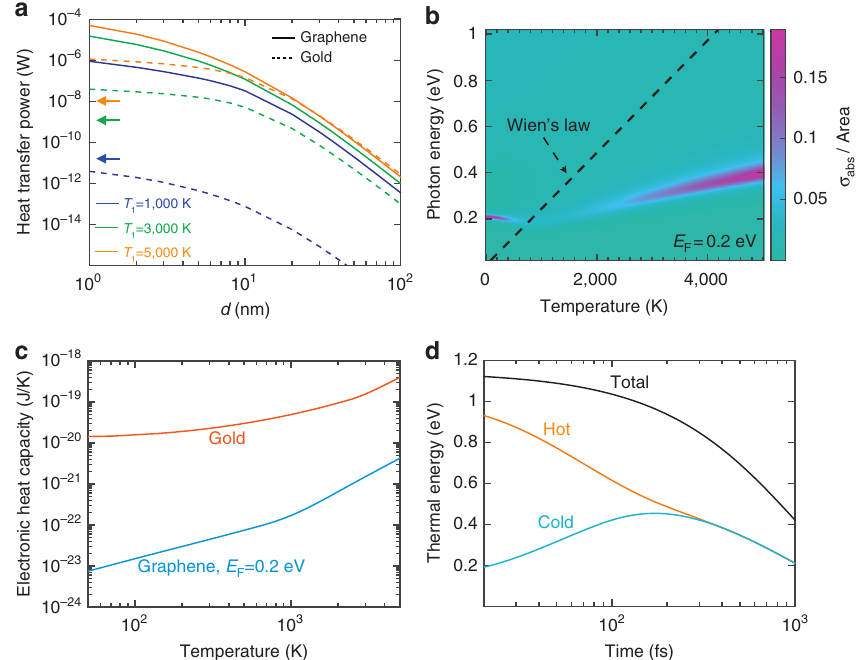
Fig. 2 Thermal and optical properties associated with radiative heat transfer. a Dependence of the radiative heat transfer power ( HTP ) on the separation distance d between two graphene nanodisks ( solid curves ) compared with two gold nanodisks ( dashed curves , disk thickness t = 2 nm). All disks are 20 nm in diameter. The HTP is plotted for different values of T 1 (see legend), while the cold disk is at ambient temperature T 2 = 300 K. The arrows indicate the HTP between two blackbodies of an area equal to that of the present disks and placed at temperatures T 1 and T 2 . Both graphene nanodisks are assumed to be doped with the same Fermi energy E F1 = E F2 = 0.2 eV and described by the local-RPA conductivity (see Methods). b Optical absorption cross-section σ abs normalized to the graphene area for one of the graphene disks considered in a as a function of photon energy (cid:1) h ω and temperature T . The dashed line corresponds to Wien ’ s law, (cid:1) h ω (cid:7) 2 : 82 k B T . c Temperature dependence of the electronic heat capacity for one of the graphene ( blue curve , see Methods) and gold ( red curve , taken from ref. 91) nanodisks considered in a . d Illustrative example of the femtosecond dynamics of the electronic thermal energy in two graphene nanodisks under the conditions of a for a separation d = 1 nm, with initial temperatures T 1 = 1,000 K and T 2 = 300 K. The electronic thermal energy is shown for both the initially hot ( orange curve ) and cold ( cyan curve ) nanodisks, as well as their sum ( black curve